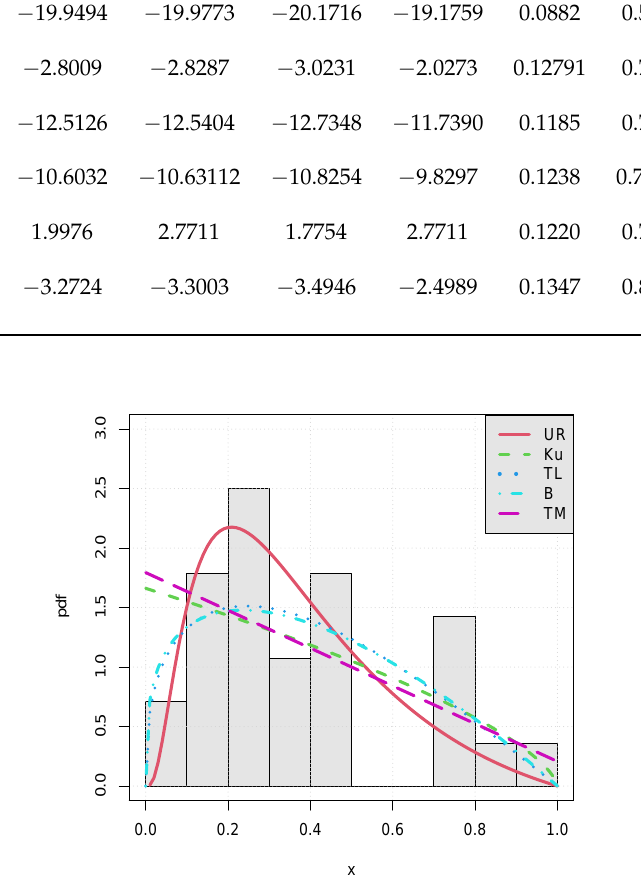
Figure 8. Plots of the estimated pdfs of the considered models for the times of infection data set.